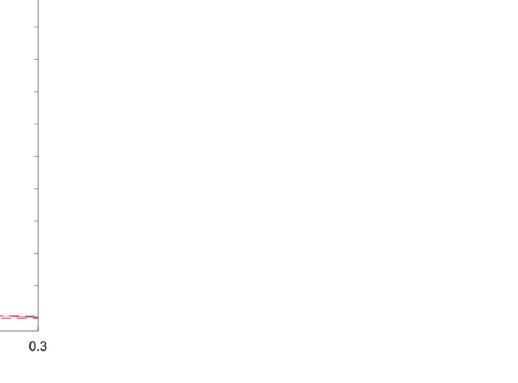
Figure 3. Ensemble of the normalized power spectrum distribution during feeding for N = 15 horses.